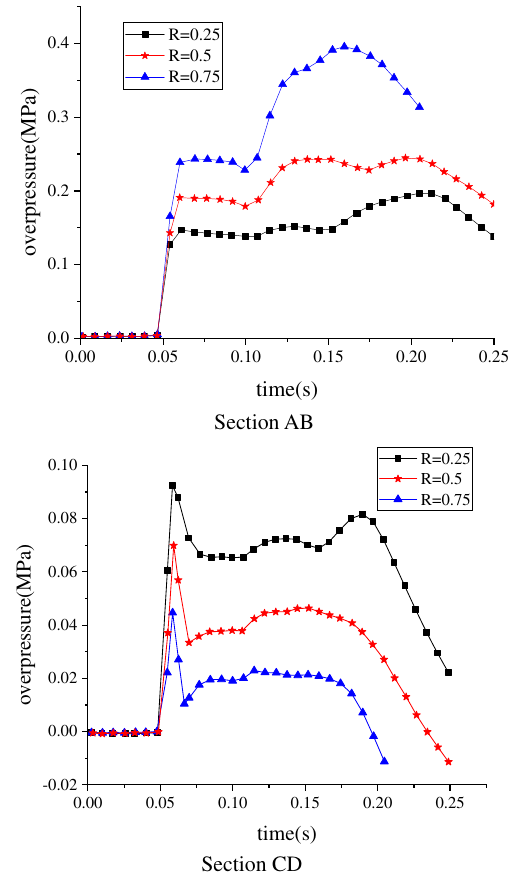
Fig. 15 Gas overpressure variation with time at different sections and for different blocking Table 1 Attenuation coefficients of shock waves for different road- way types Type of roadway